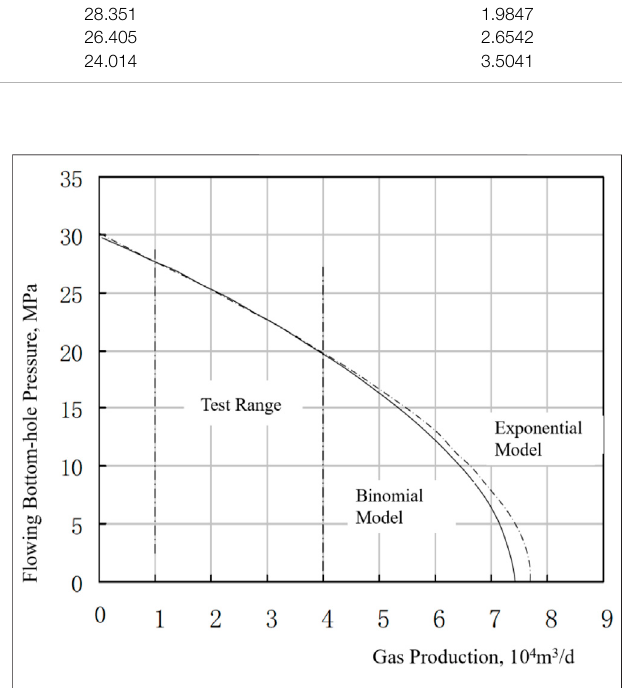
FIGURE 3 | Comparison of in fl ow performance relationship curves produced by different productivity